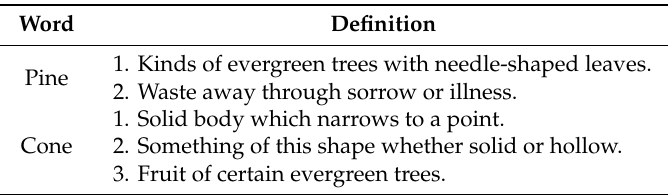
Table 2. Definitions for “pine” and